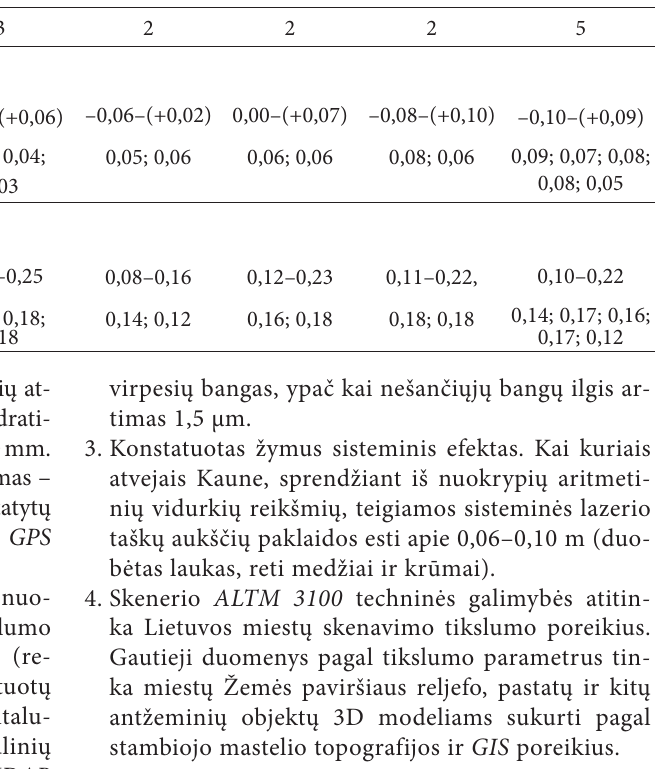
Table 7. Some results of JSC InfoERA investigations of laser pulse point’s position accuracy Tikslumo